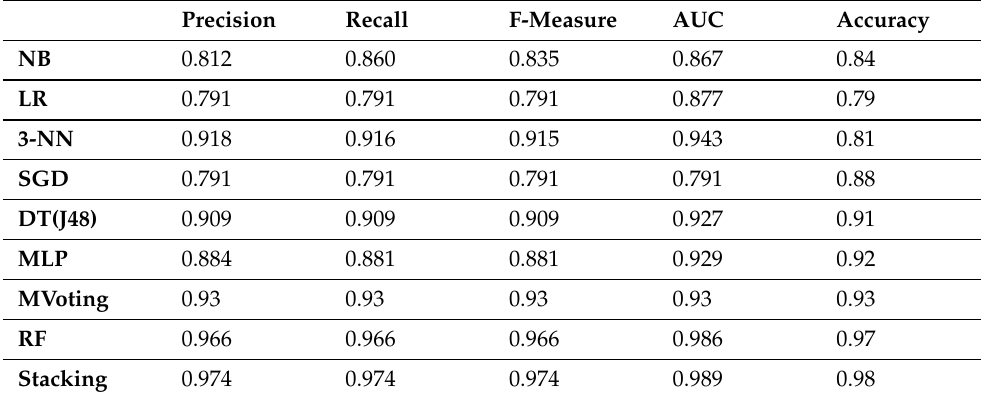
Figure 6. Machine learning models precision and recall evaluation for the stroke class. Table 2. Average performance of ML